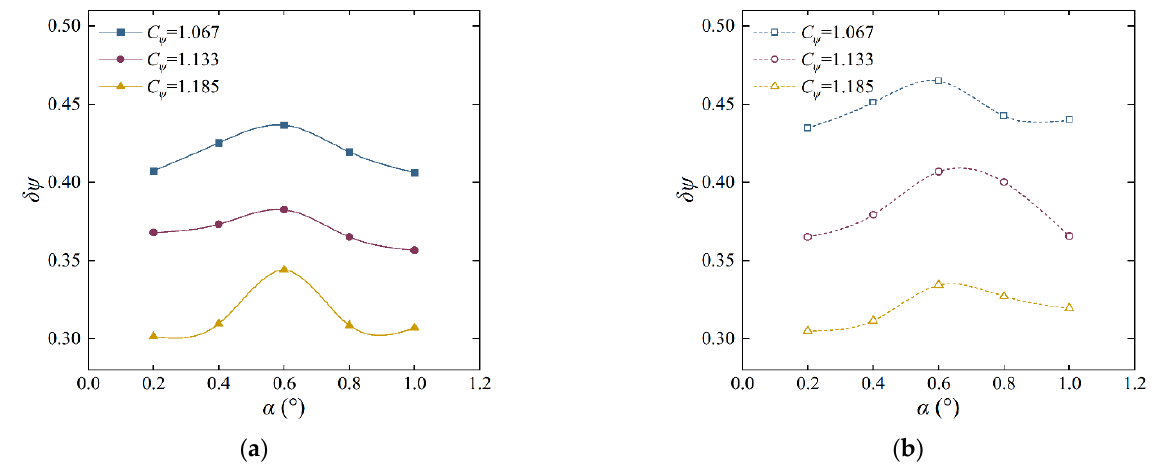
( b ) Figure 10. Flow rate coefficient in pump mode with respect to GV opening angle under conditions of different head coefficients. ( a ) GV-O; ( b ) GV-M. To evaluate the instability of GV torsional vibration, URANS-1DOF coupling simu-